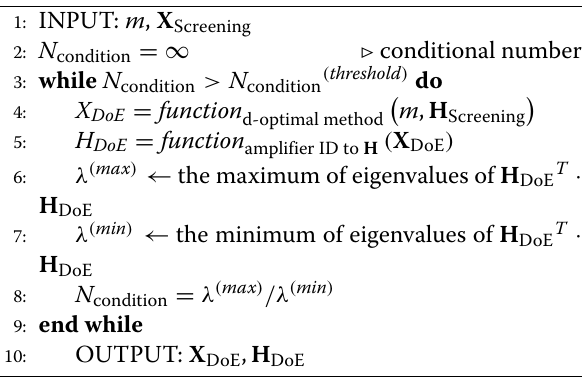
Algorithm 1 The DoE Approach: find X DoE (a set of sample configurations) and a matrix H DoE in (15).